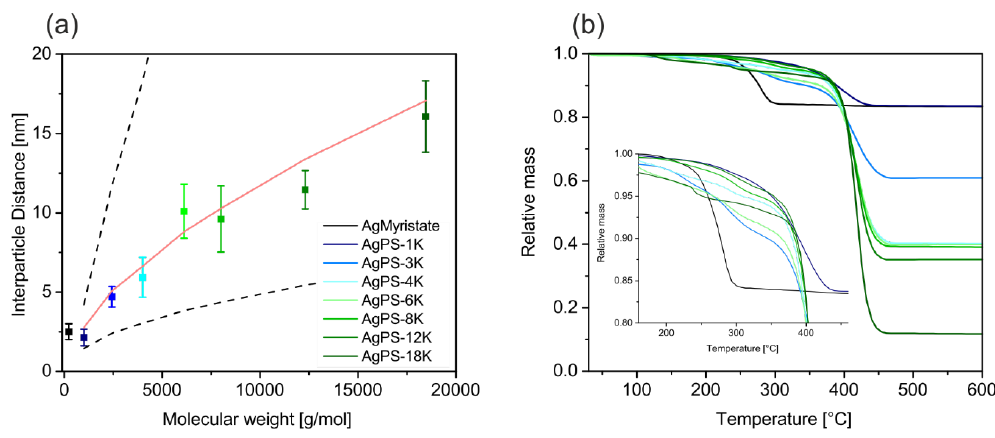
Figure 5. ( a ) The edge-to-edge interparticle distance in the nanocomposites increases systematically with higher molecular weight. The dashed lines present the upper (fully-stretched chain) and lower limit (random coil R g ≈ l 0 N 1/2 ). The red line was calculated by Equation (2) and represents the theoretical interparticle distance of a polymer brush in the semi dilute regime. ( b ) TGA curves of the nanocomposites and of pure silver particles with myristate ligand as a reference. The inset emphasizes the onset of thermal degradation. The myristate ligand decomposes at much lower temperatures than the polystyrene ligand.